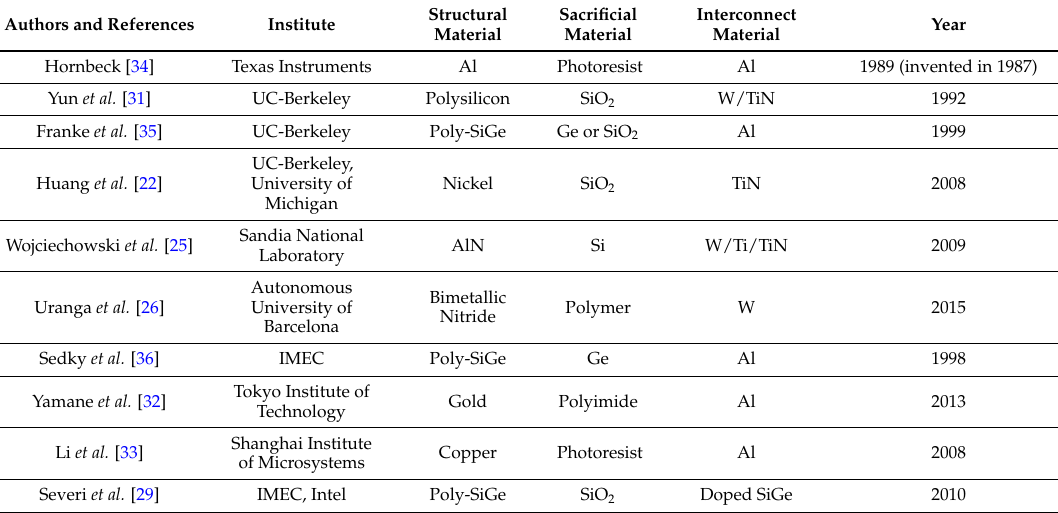
Table 1. Representative additive post-CMOS MEMS technologies and